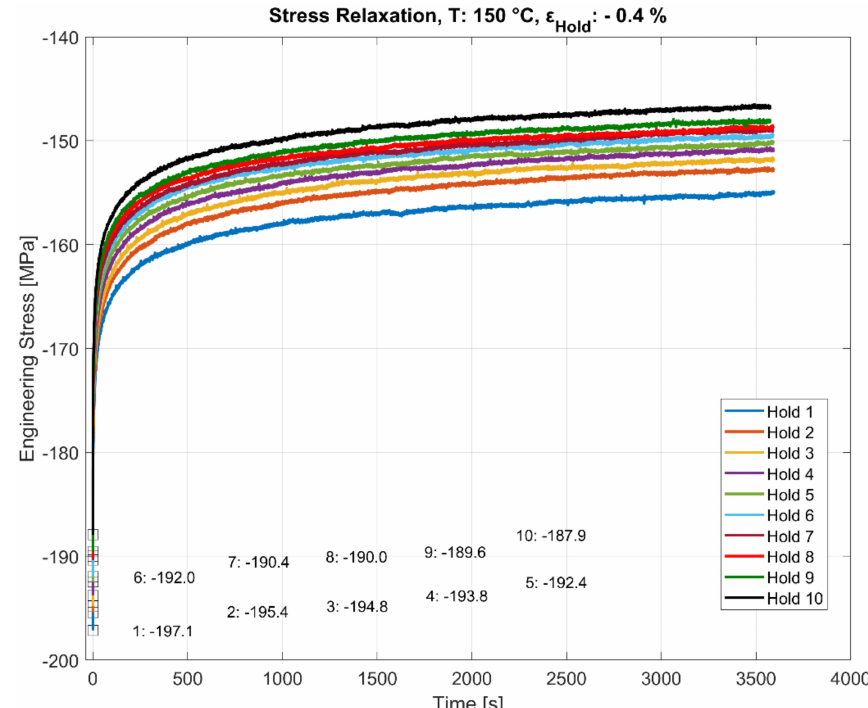
Figure 10. E ff ect of hold time on stress relaxation at 150 ◦ C with alternating fatigue loading and hold period. The start (trough) values at the beginning of each hold period (numbered 1–10) are stated in